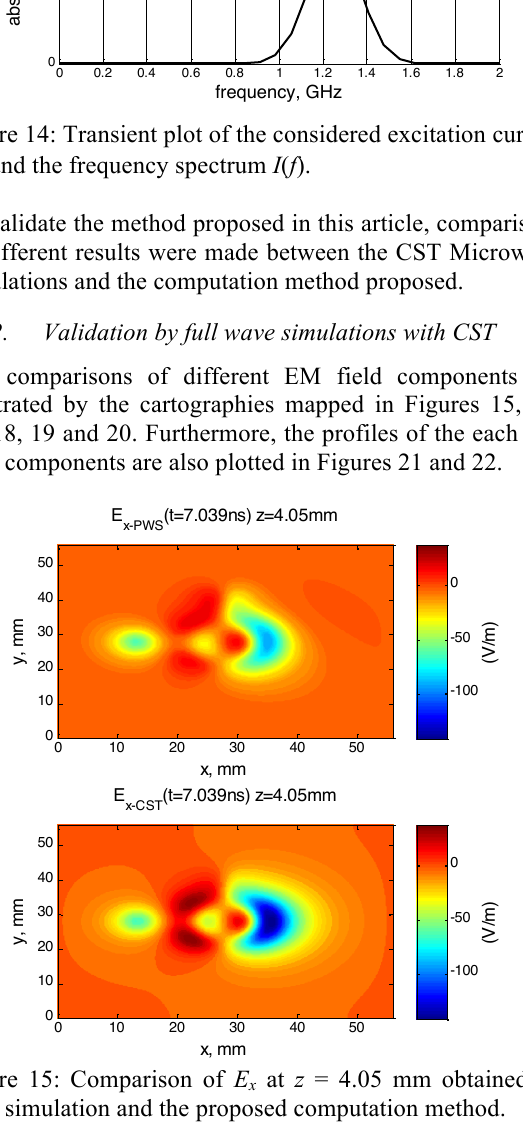
at z = 4.05 mm obtained by x